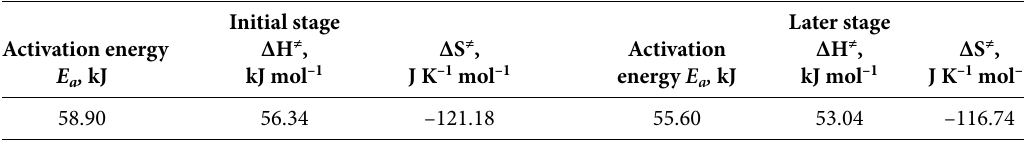
Table 2. Activation parameters for different stages of silver nanoparticles formation using PTHQ. Initial stage Later stage Activation